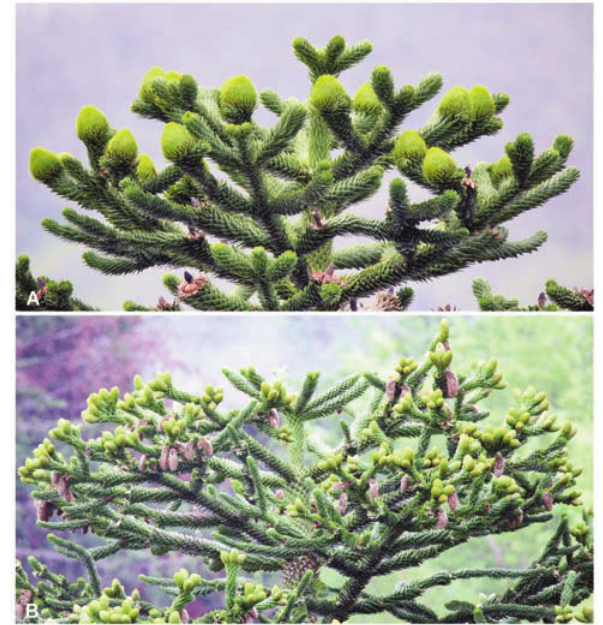
Fig. 2 - Totally differentiated Araucaria araucana female (A) and male (B) trees grown in Pistoia’s high hills, showing stro- biles and catkins formed in consecutive